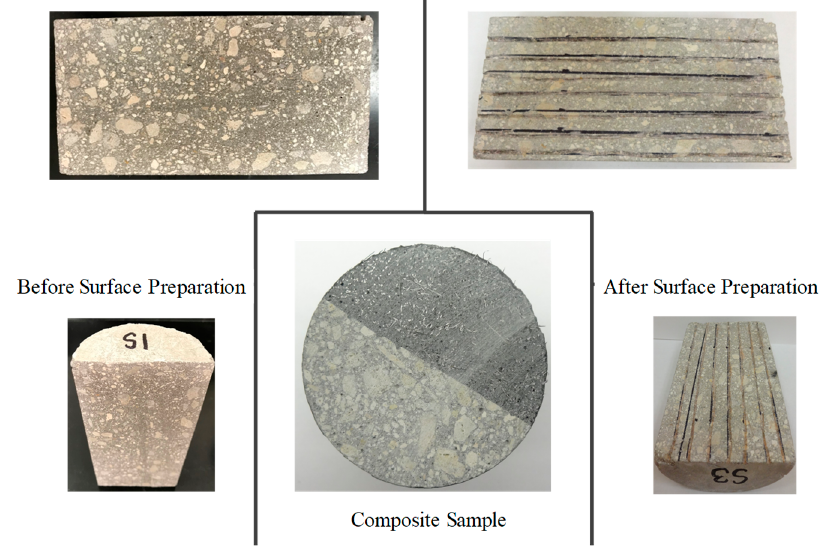
Figure 1. The process of sample preparation.